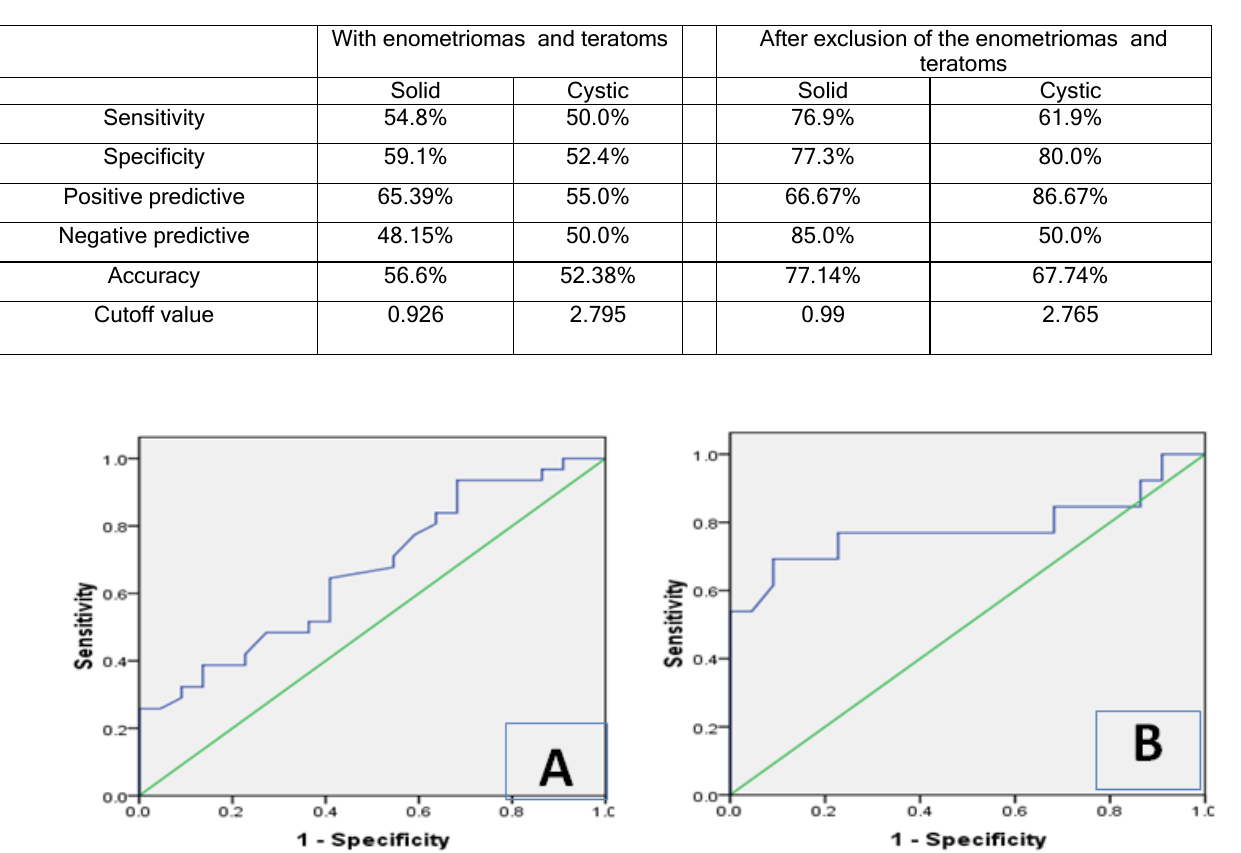
Table 7: Cut off value, sensitivity and the specificity of ADC values in the solid and cystic components of the benign and malignant ovarian lesions: